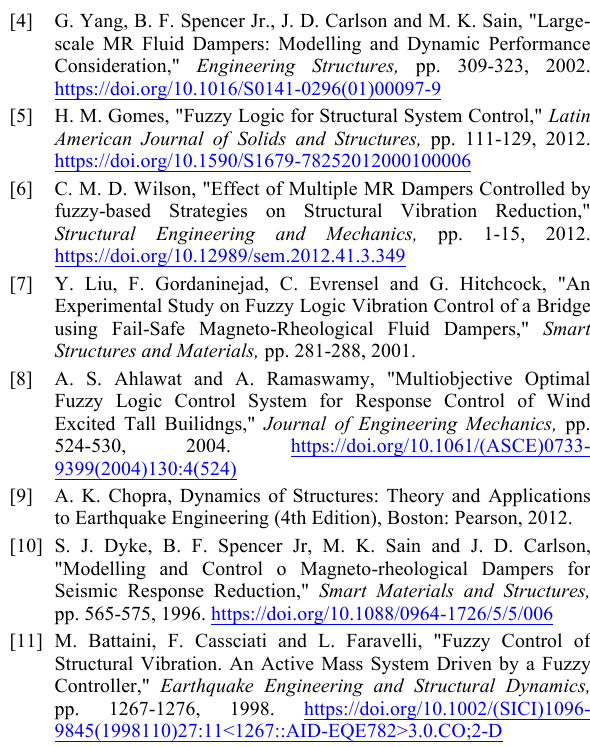
Figure 7. Comparing controlled and uncontrolled displacement at different floors for different dampers’ arrangements under Kern Country Earthquake.